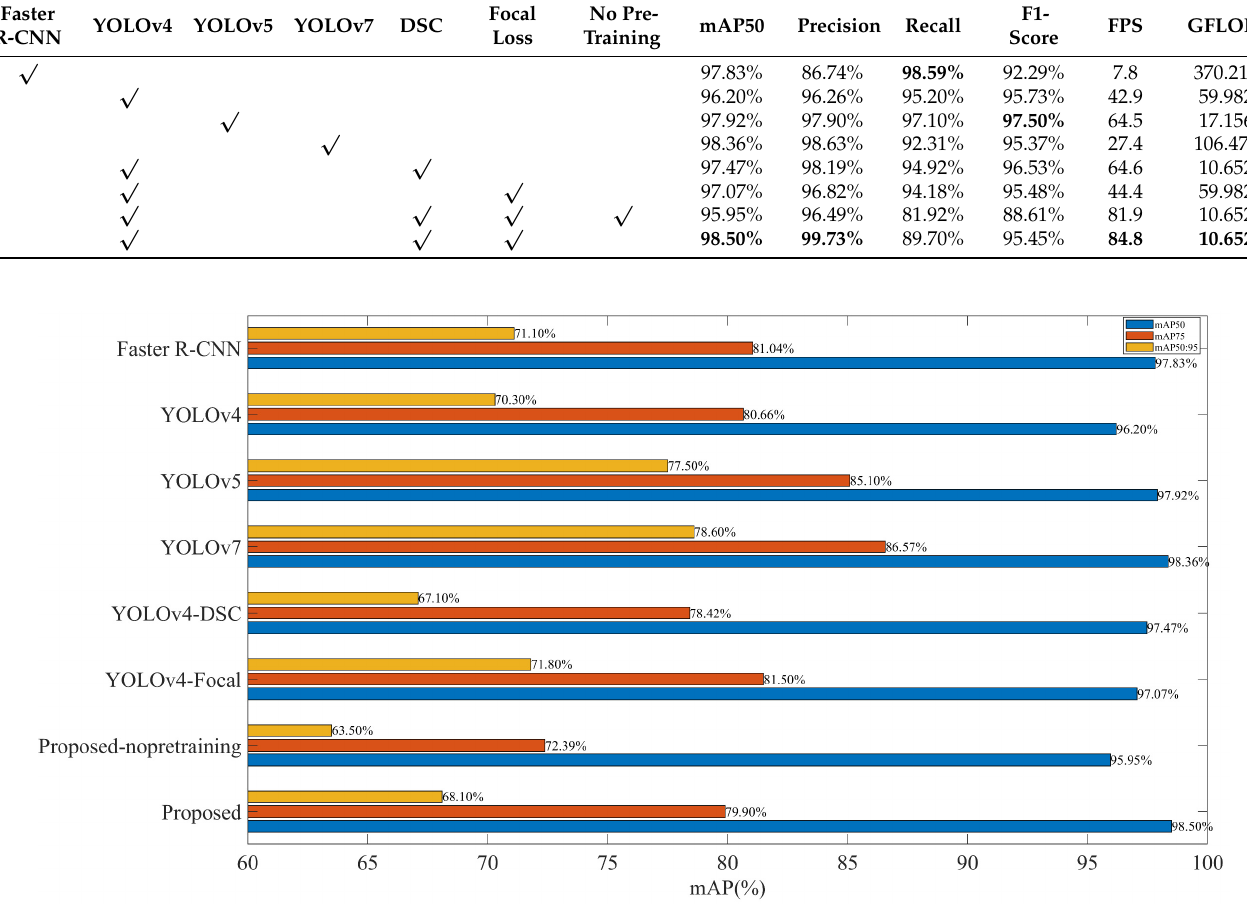
Figure 17. Comparison of mAP values of the different algorithms.